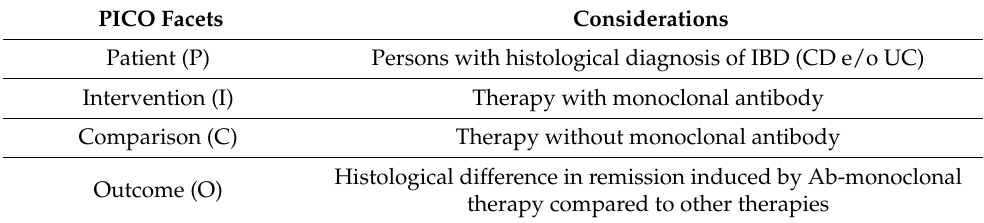
Table 1. PICO statements utilized in this review.